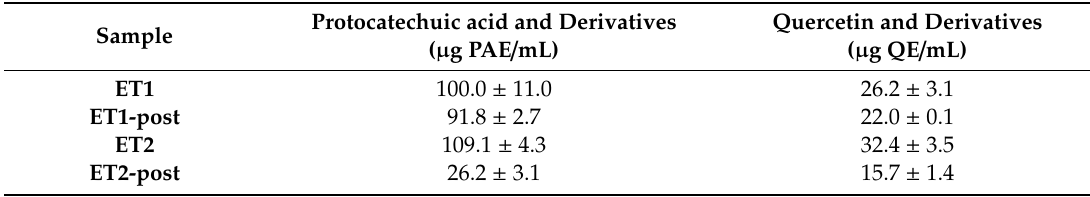
Table 3. Quantitative analysis of protocatechuic acid, quercetin, and their glucosides in onion extracts and their residue after dyeing procedures. Data are expressed as mean ( n = 3) ±